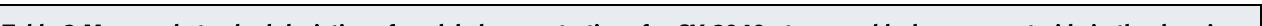
Table 2 Mean and standard deviation of modeled concentrations for CY 2040 at census block group centroids in the domain. Scenario PM